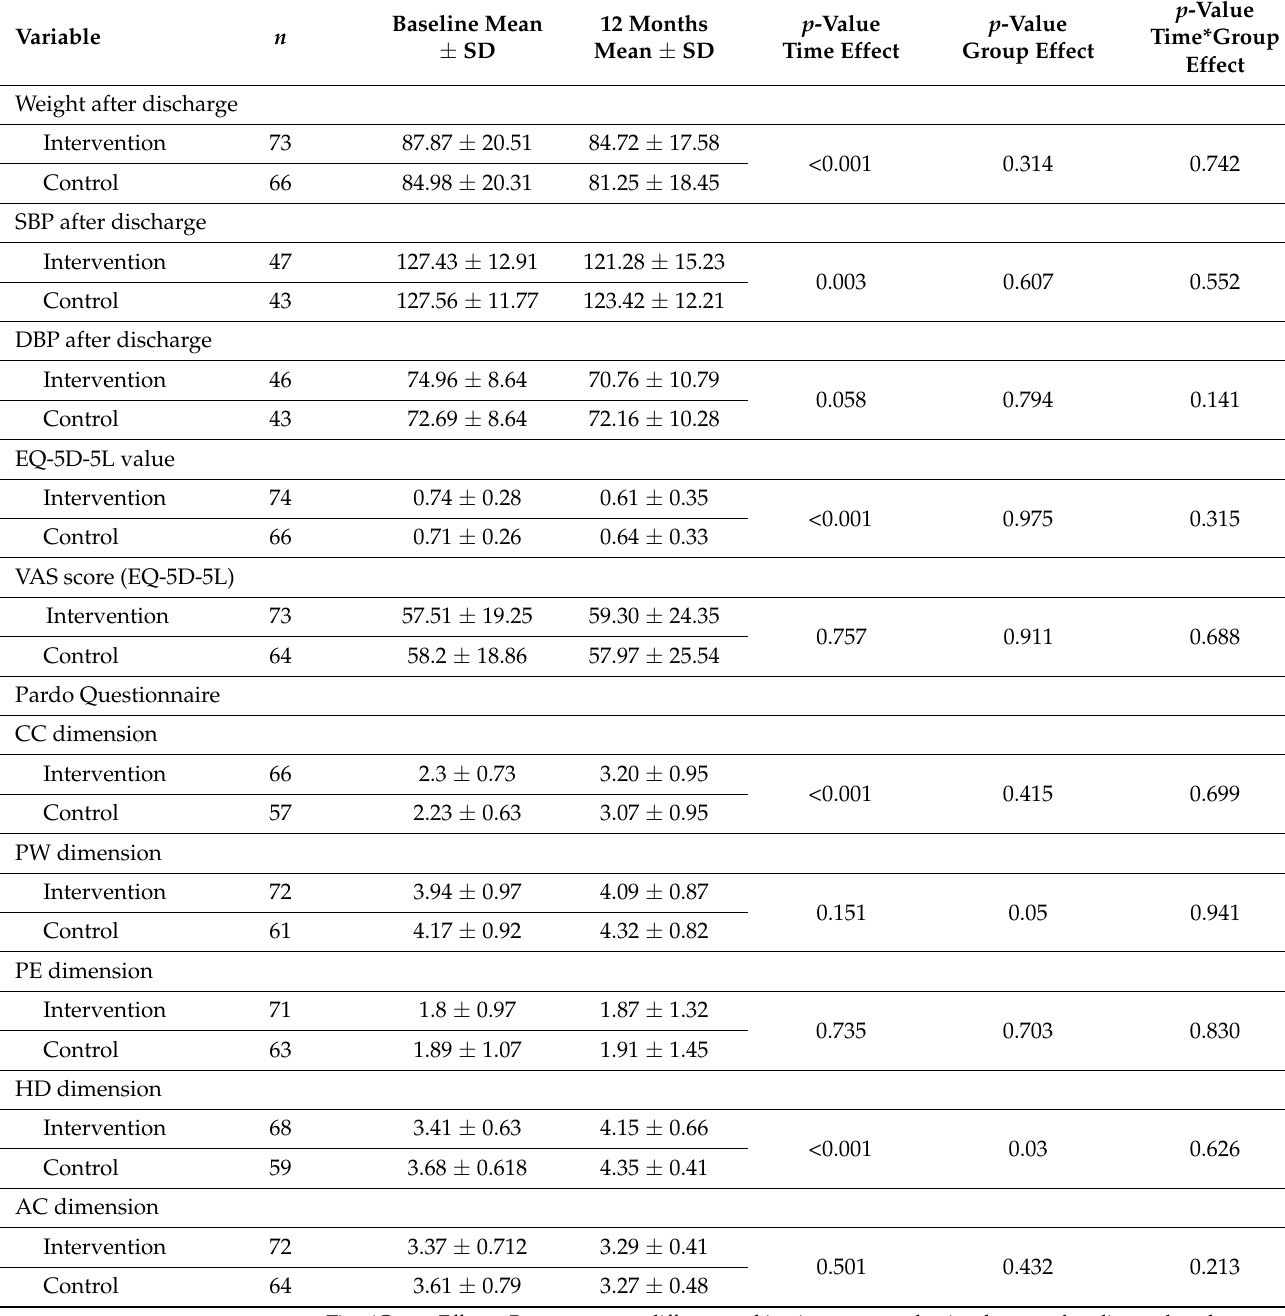
Table 5. Comparison of outcome variables between baseline and 12